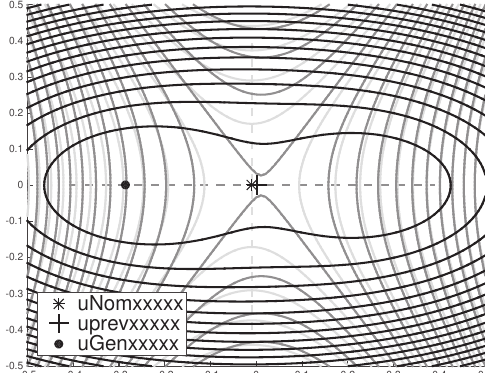
Figure 5. Example of the problem where the quadratic approximation (58) is unbounded, while (53) has a solution. The black lines report the level curves of the cost of Problem (67); the grey lines report the level curves of the cost of Problem (68); and the light grey lines report the level curves of the cost of Problem (69) with Q given by (63). In this example, ignoring the contribution of ∇ 2 φ 0 in the Directional-Modifier Adaptation (DMA) algorithm leads it to privilege directions (light grey dashed line) that are significantly different from the ones privileged by (67) (grey dashed line). The latter point to the solution of the original Problem (53).